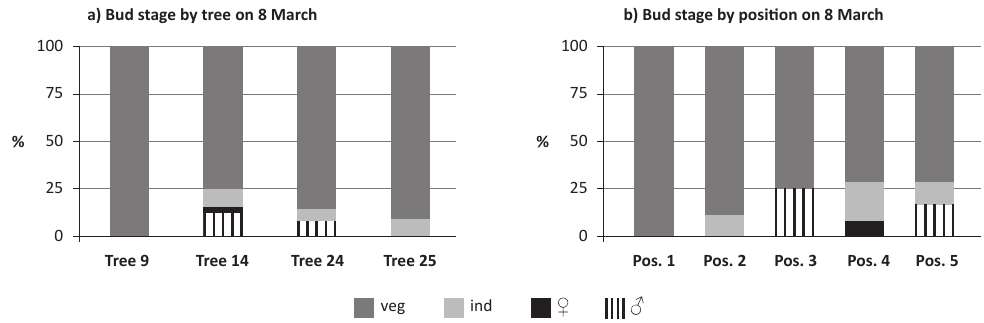
FiGure 3. Quantification of bud determination comparing tree and bud positions (pos.) on a branch (veg - vegetative, ind - undifferentiated, /veg - primordia of female inflorescences with vegetative buds, primordia of male inflorescences by 8 March